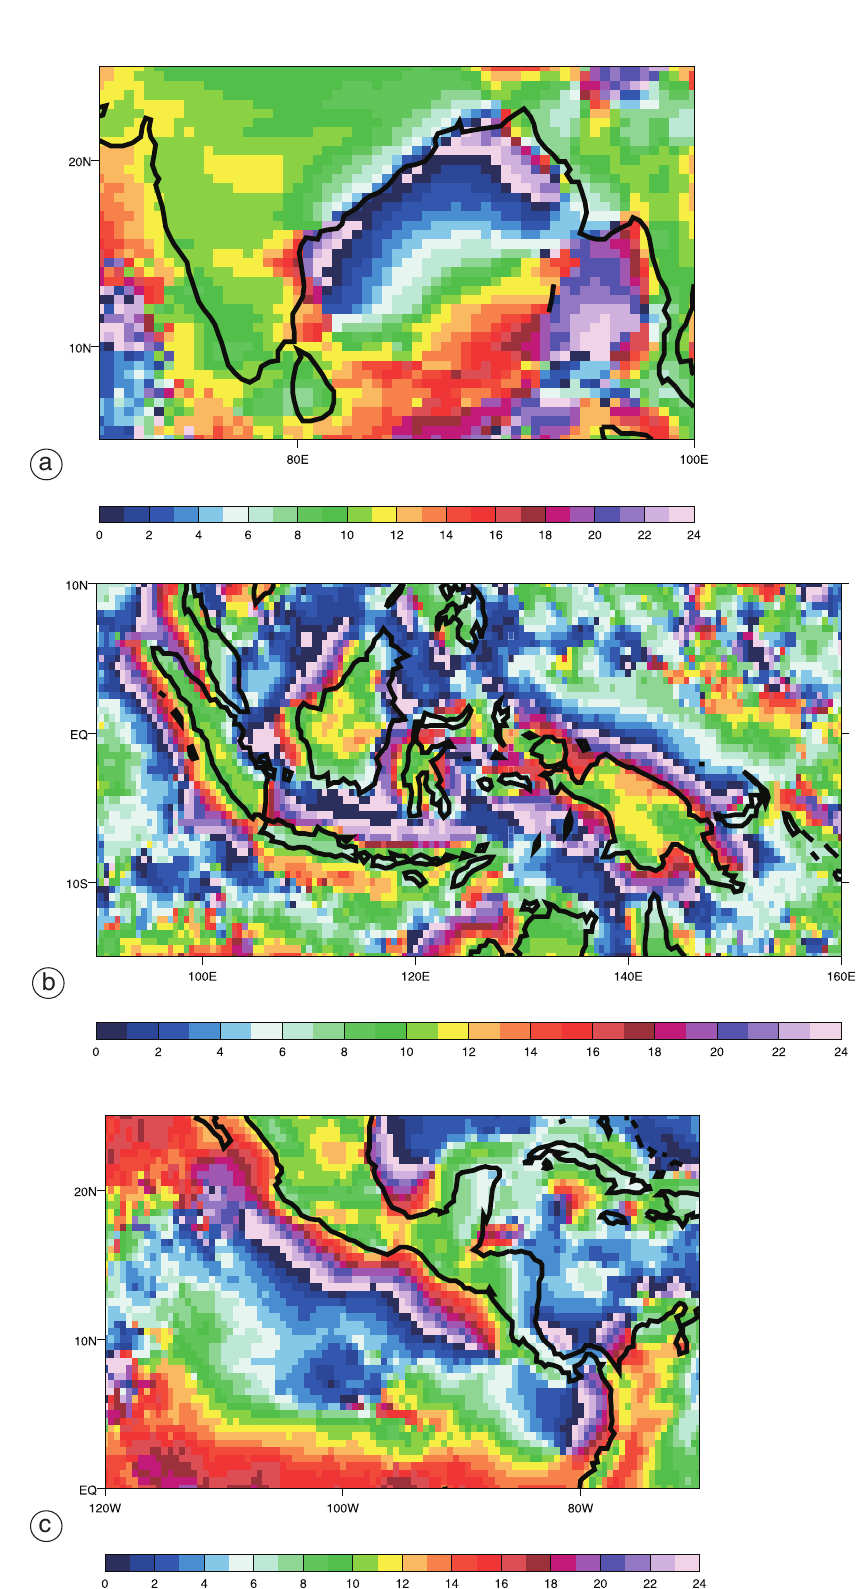
Fig. 5a-c. Phase of the diurnal harmonic of brightness temperature over (a) Bay of Bengal in JJA, (b) Maritime Continent in DJF, and (c) Mexican coast in JJA. Phase is given in terms of the local time of the maximum. Based on Yang and Slingo